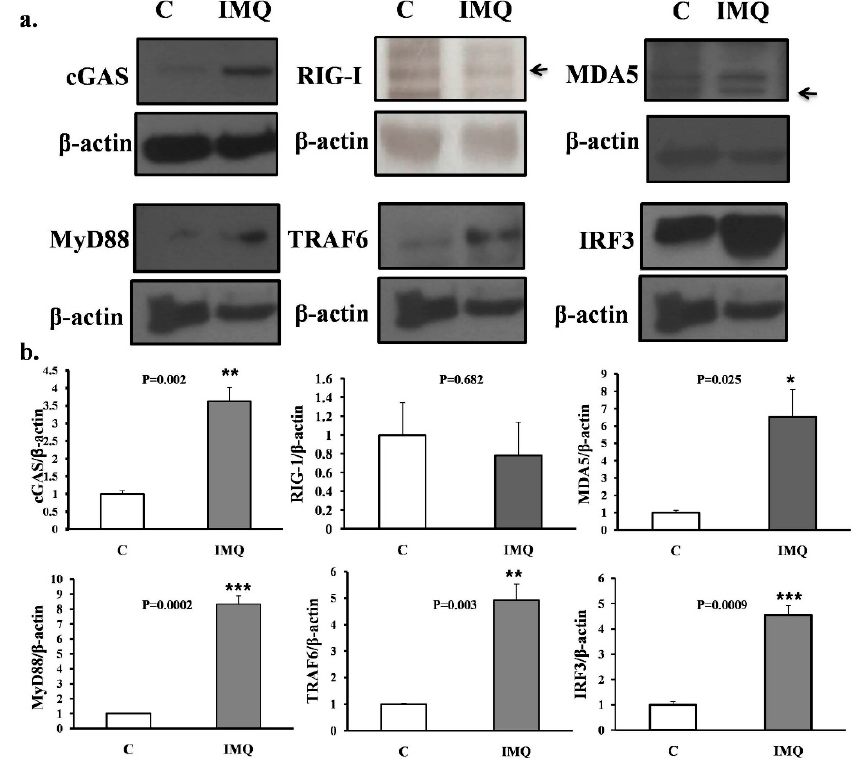
Figure 3. ( a ) Western blot results. ( b ) Histograms of intracellular proteins inside B cells. Western blot results of intracellular proteins inside B cells. Those B cells either from IMQ-stimulated or non-stimulated mice were co-cultured with CD40L feeder cells for 7 days and were then retrieved for analysis. Cytosolic protein was separated with the centrifuge method and blotted with antibodies against mouse cGAS, RIG-1, MDA5, MyD88, TRAF6, and IRF3, as shown in the upper part of the figure. The histograms are shown in the lower part of the figure. All the experiments were repeatedly performed at least three times and the comparison between groups, control (C), and IMQ-treated (IMQ), were calculated with the Mann–Whitney test. The mark * indicates a p -value less than 0.05. ** indicates a p -value less than 0.01. *** indicates a p -value less than 0.001.